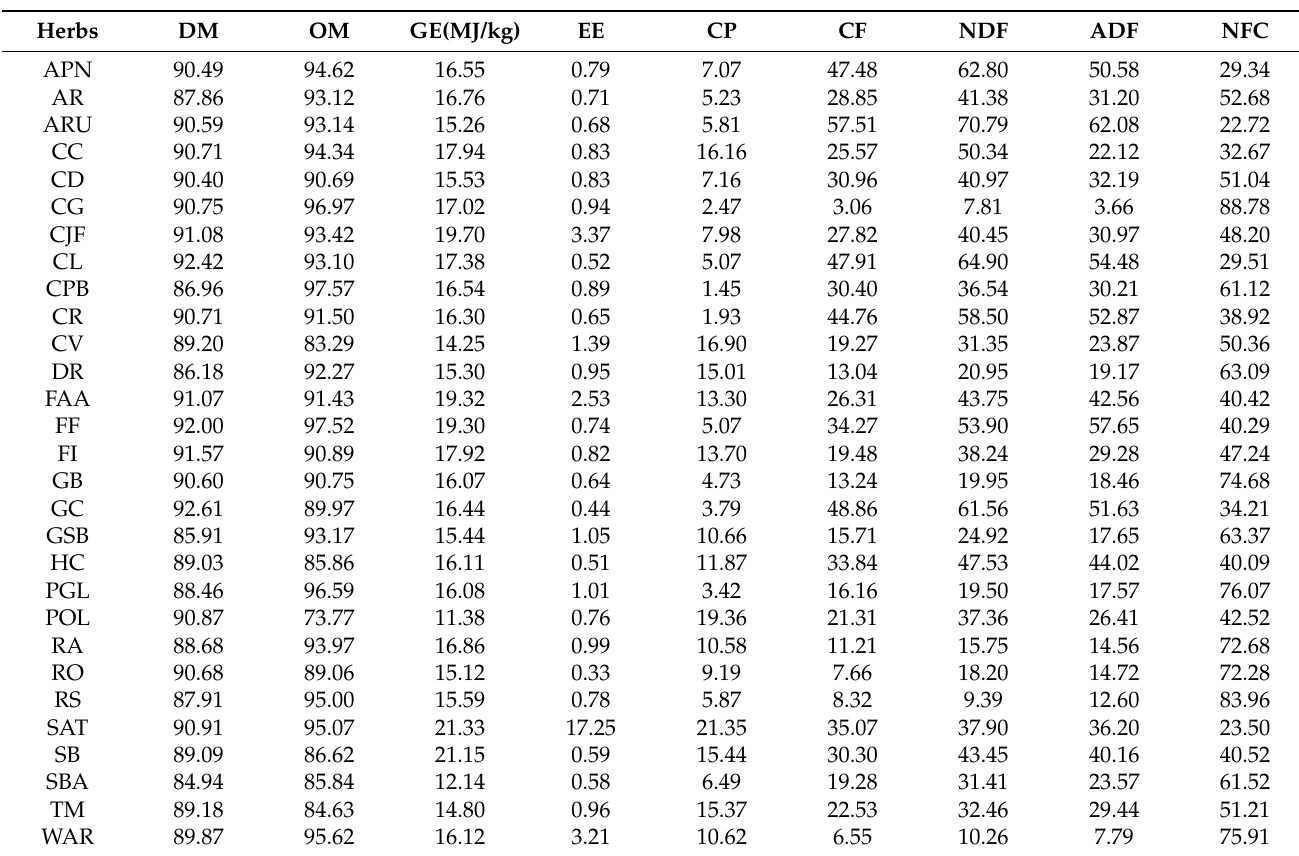
Table 2. Routine nutritional composition of 29 different Chinese herbs (% of